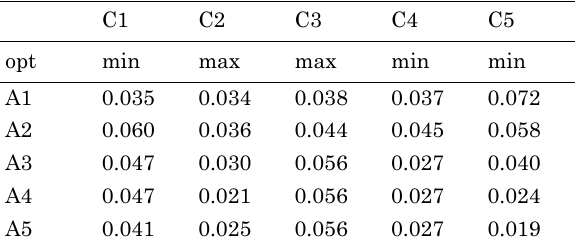
Table 6. Weighted normalized matrix